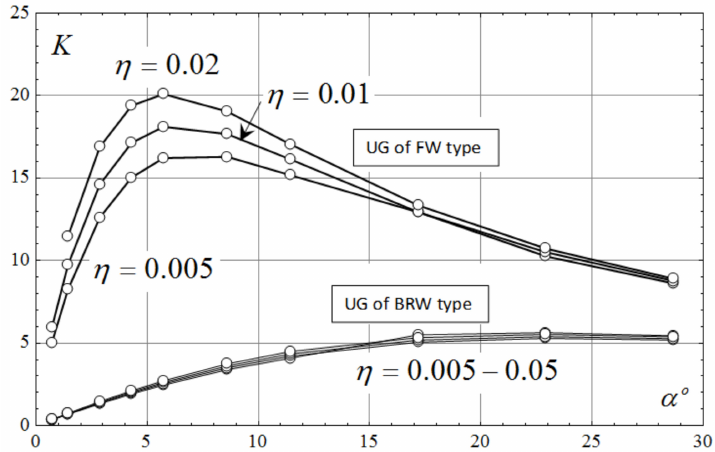
Figure 7. Hydrodynamic quality versus angle of attack for BRW-type and FW-type vehicles for different magnitudes of relative differential buoyancy ( V 0 = 0.042 m 3 )